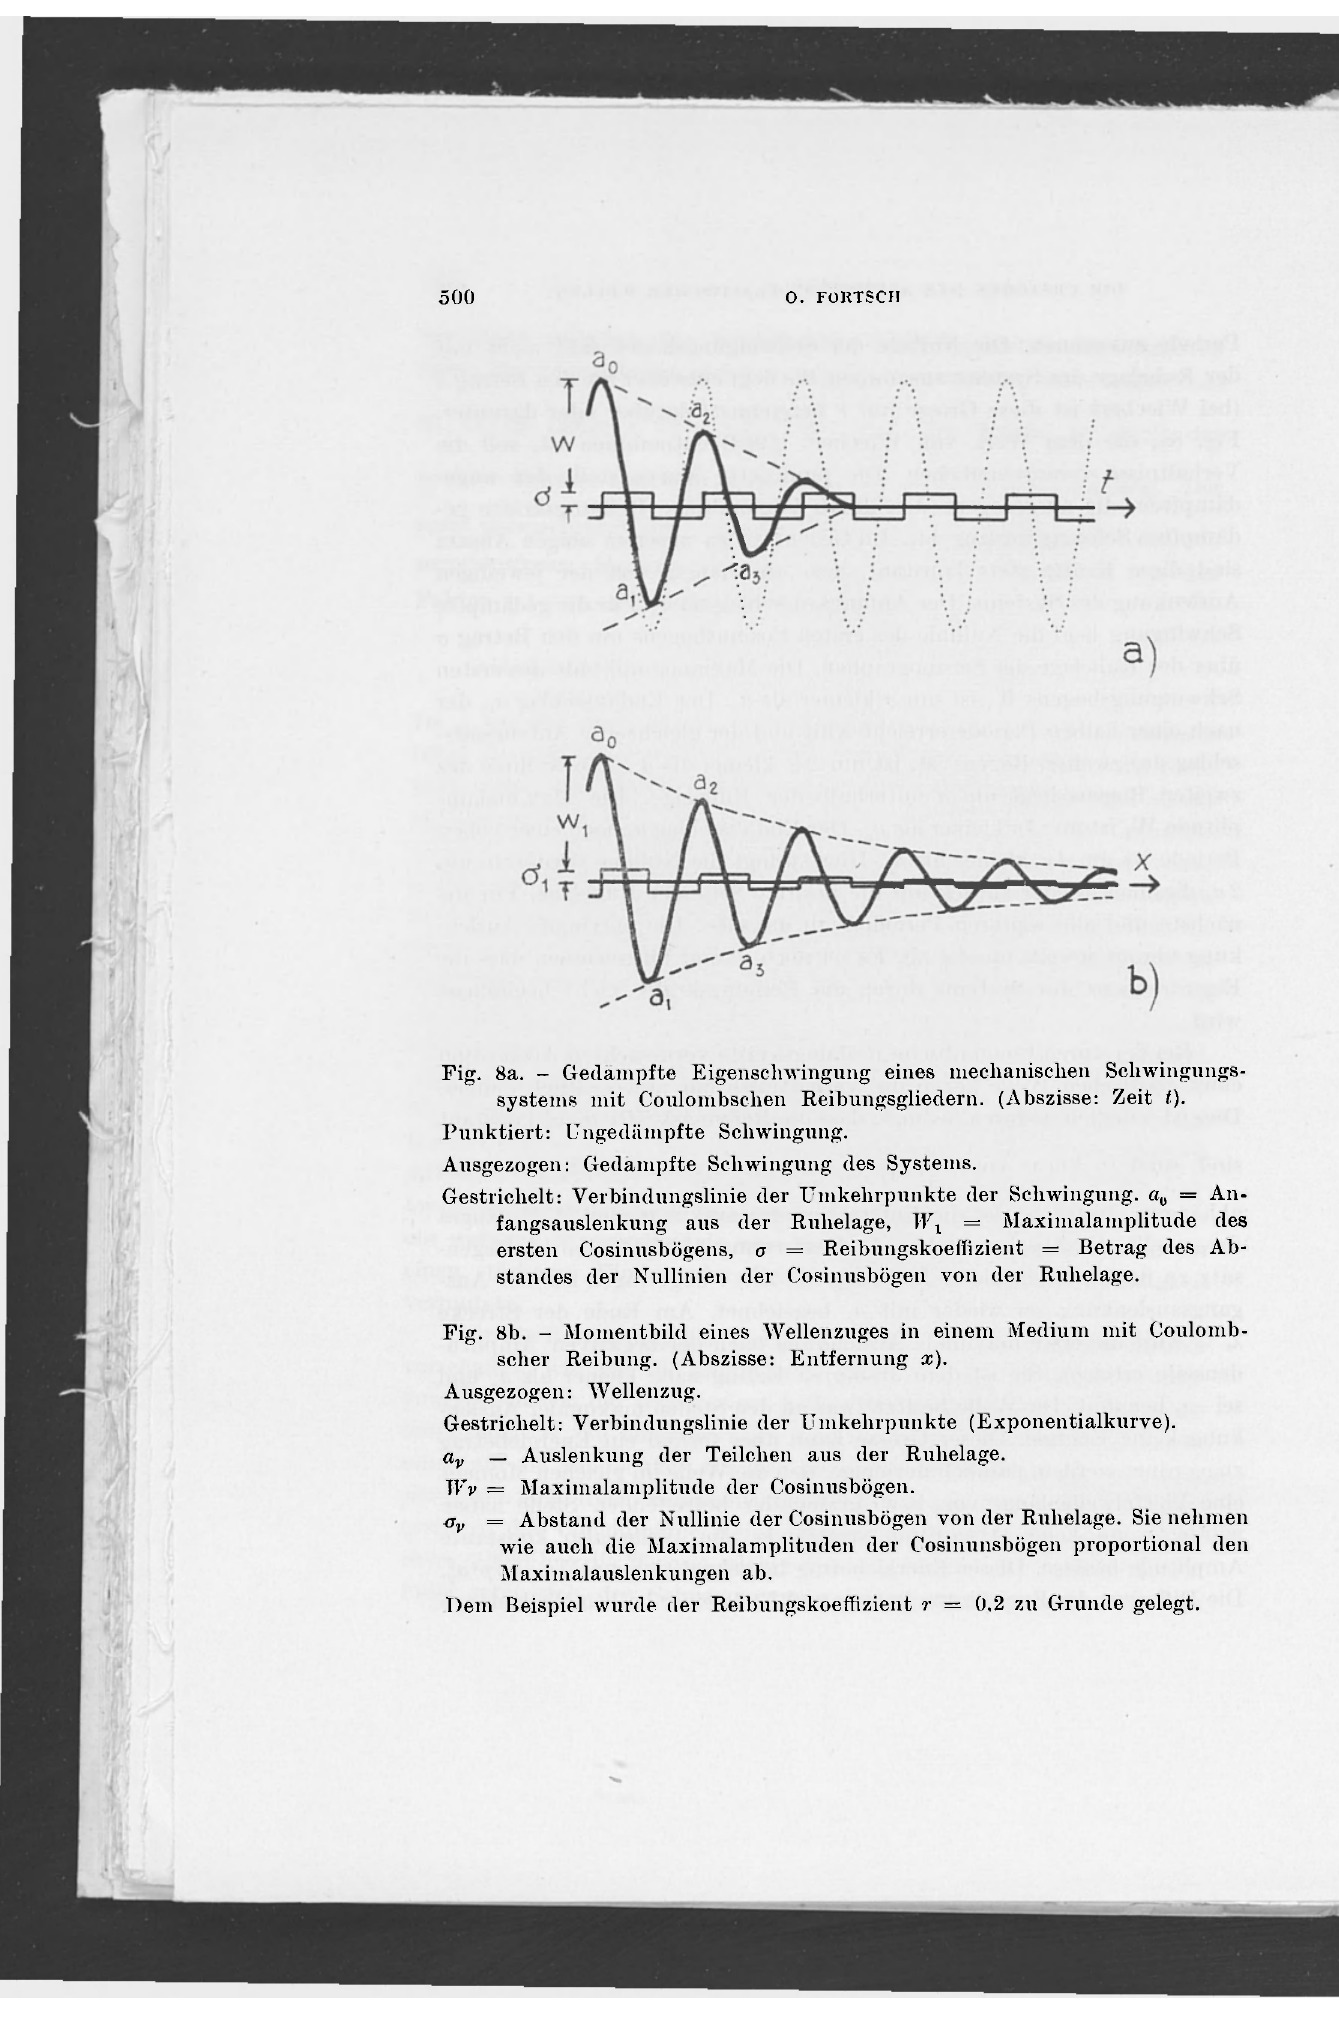
Fig. 8b. - Momentbild eines Wellenzuges in einem Medium mit Coulomb- scher Reibung. (Àbszisse: Entfernung